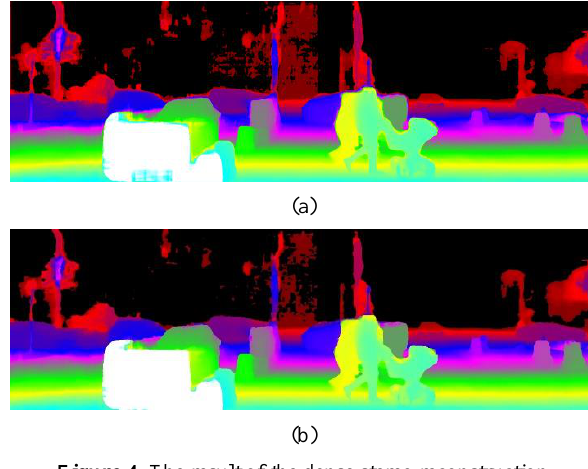
Figure 4 . The result of the dense stereo reconstruction algorithm (a), result after postprocessing (b).